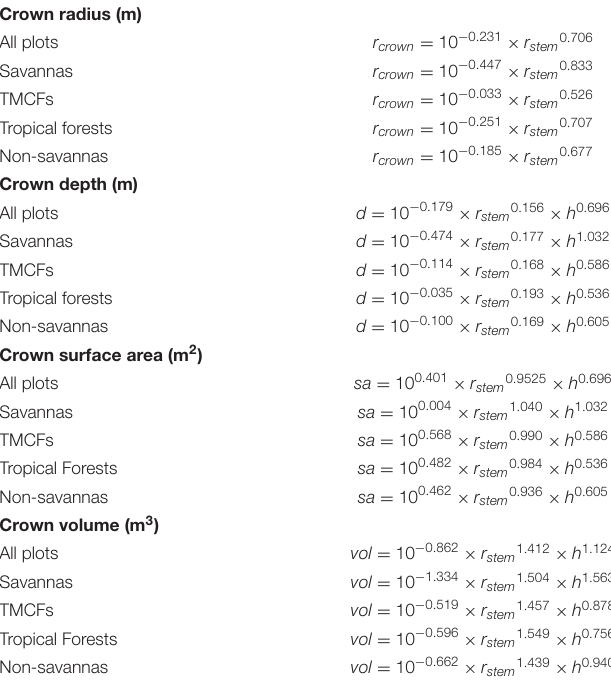
TABLE 4 | Allometric models for crown dimensions across different